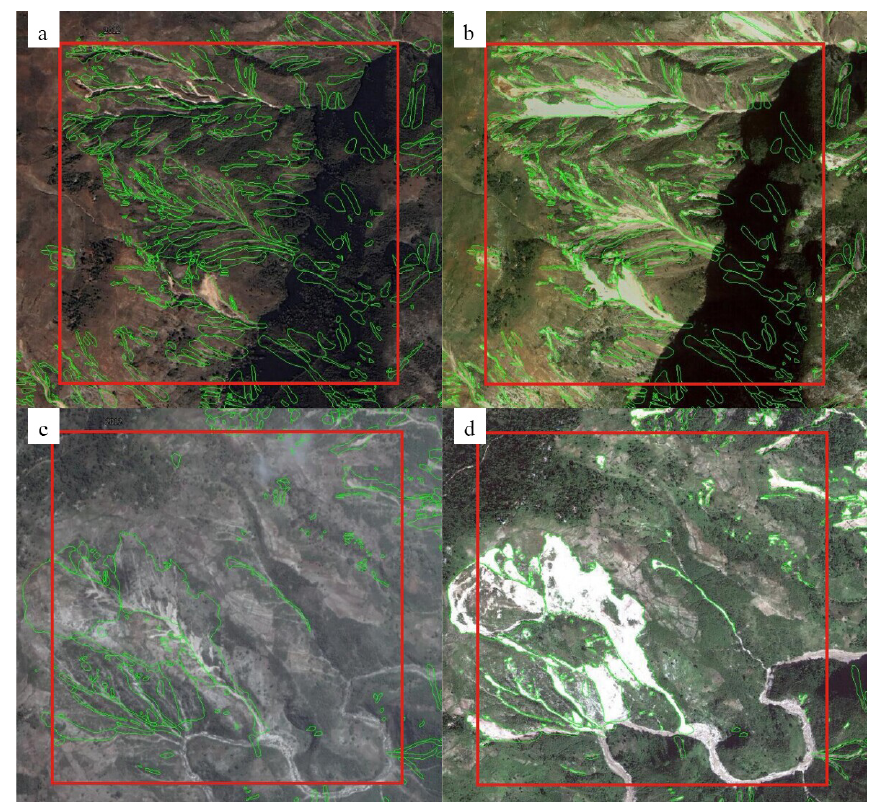
Figure 11. Examples of 1km × 1km grids pre- and post-earthquake images. (a) taken on 4 February 2009, (b) taken on 21 January 2010, (c) taken on 2 June 2005, and (d) taken on 23 October 2010. The red square in (a) and (b) shows the grid of the largest landslide number density and landslide area percentage located in grid (a) in Fig. 10, and the red square in (c) and (d) shows the grid of the largest landslide erosion thickness located in grid (b) in Fig.